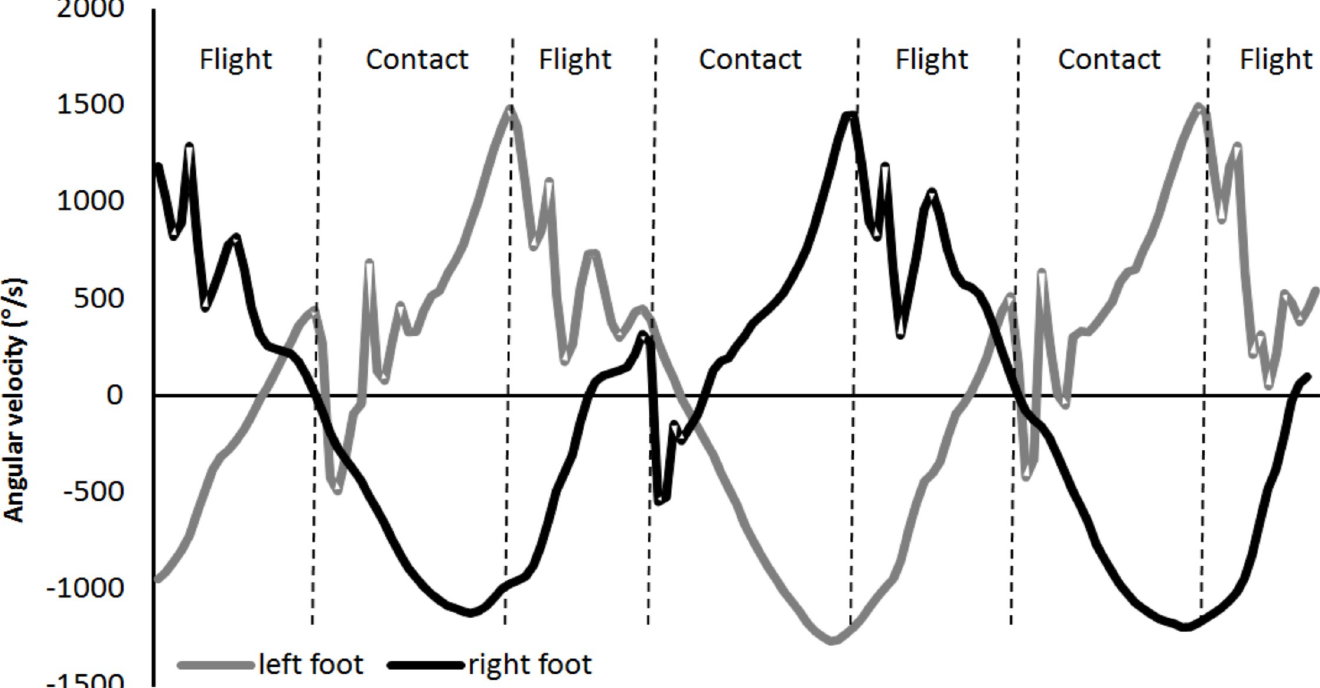
Fig 2. A typical example of three steps of the raw plantar flexion pattern measured with an IMU attached on the left and right foot with corresponding identified contact and flight time phases.